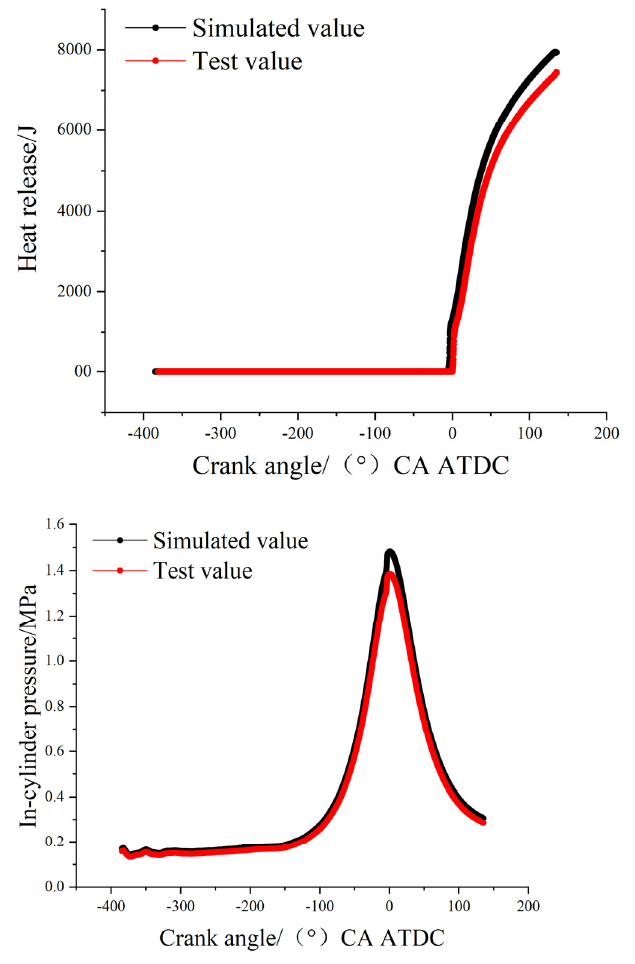
Figure 2. Comparison of numerical and experimental pressure and heat release in the cylinder.